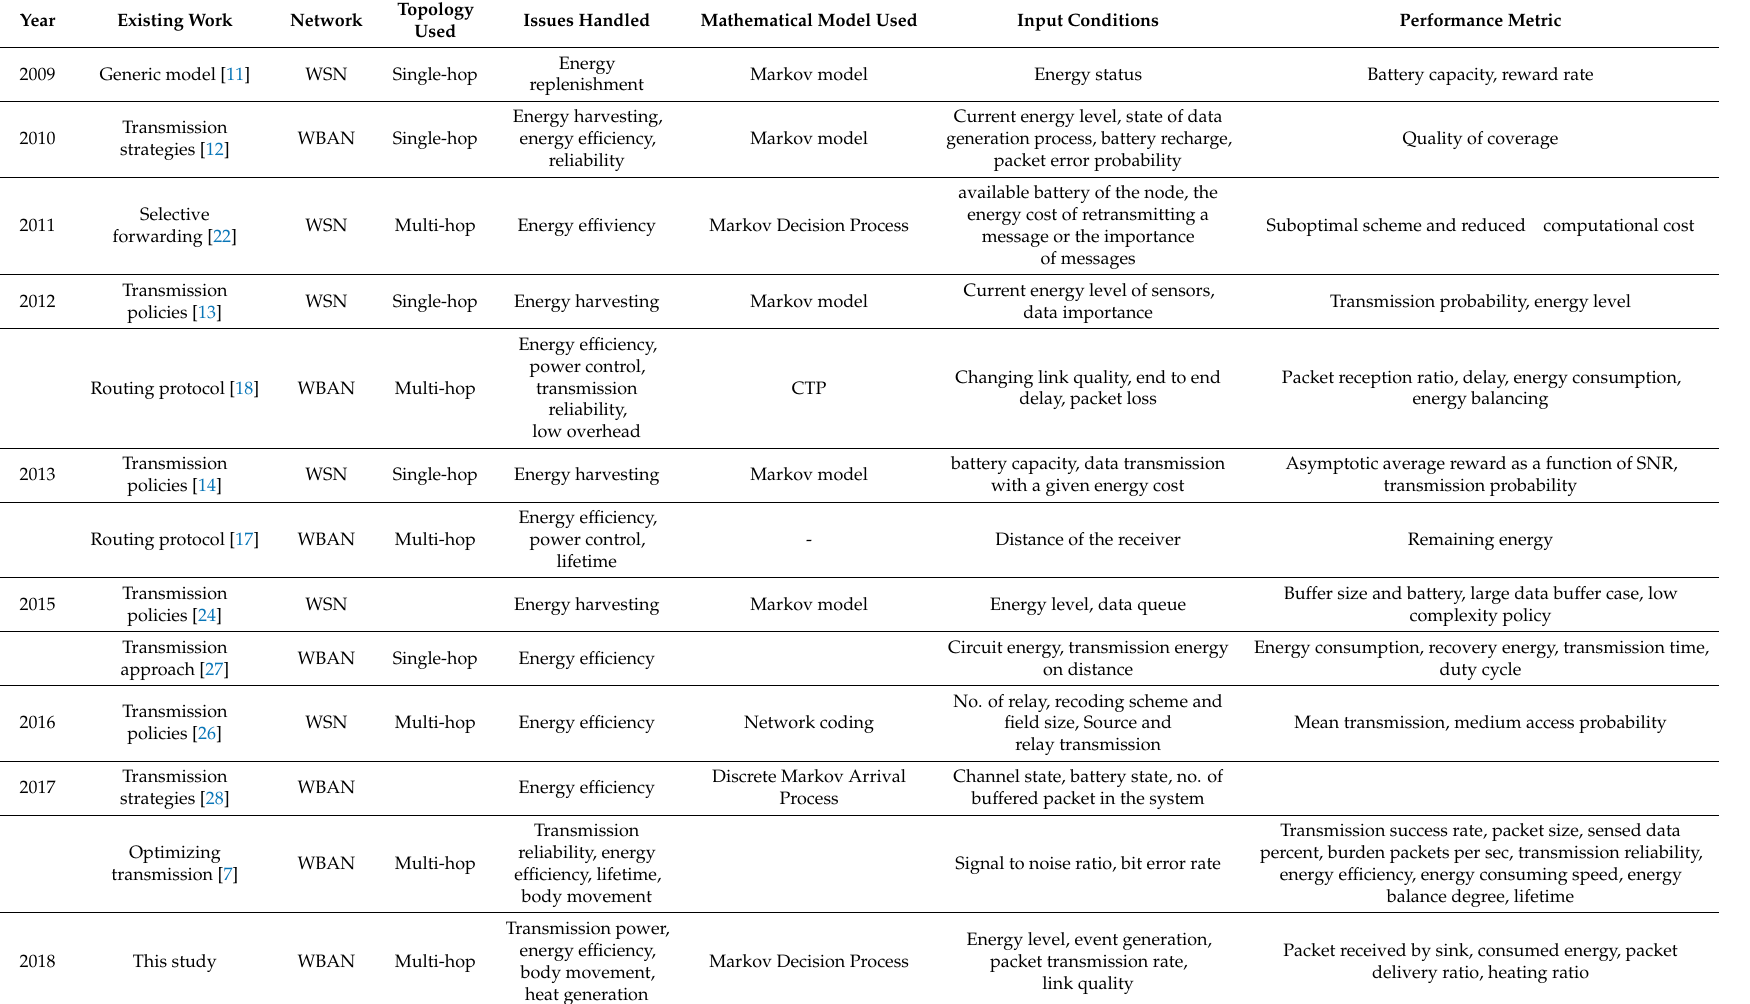
Table 1. Research work on developing transmission strategies published since